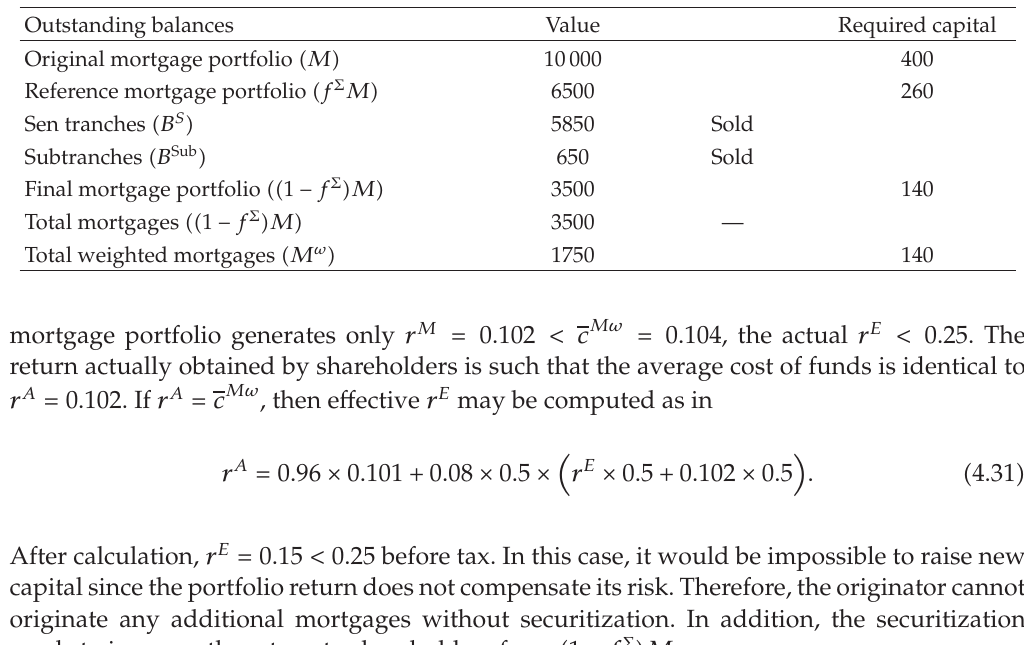
Table 5: Required capital before and after